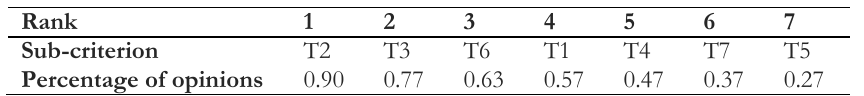
Table 7. Sort of sub-criteria in order of importance.